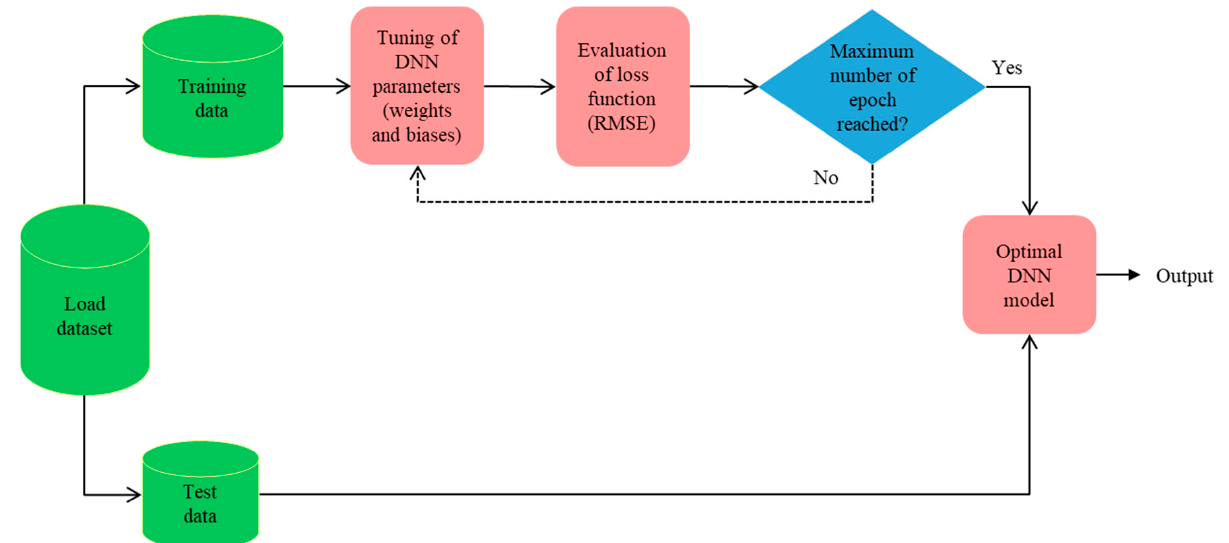
Figure 4. Process flow chart of the deep neural network (DNN).